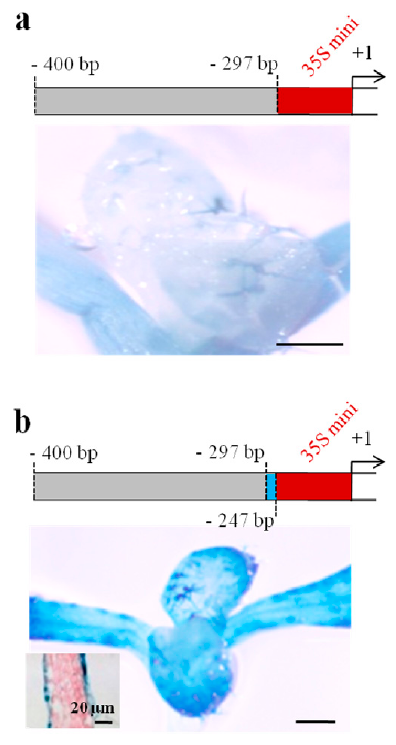
Figure 2. Activities of TaLTP1 promoter fragment fused to minimal promoter of CaMV 35S in transgenic A. thaliana. The promoter fragment from positions − 400 bp to − 297 ( a ) / − 247 bp ( b ) were fused to CaMV 35S minimal promoter and transformed into A. thaliana for activity examination. Scale bar = 200 μ